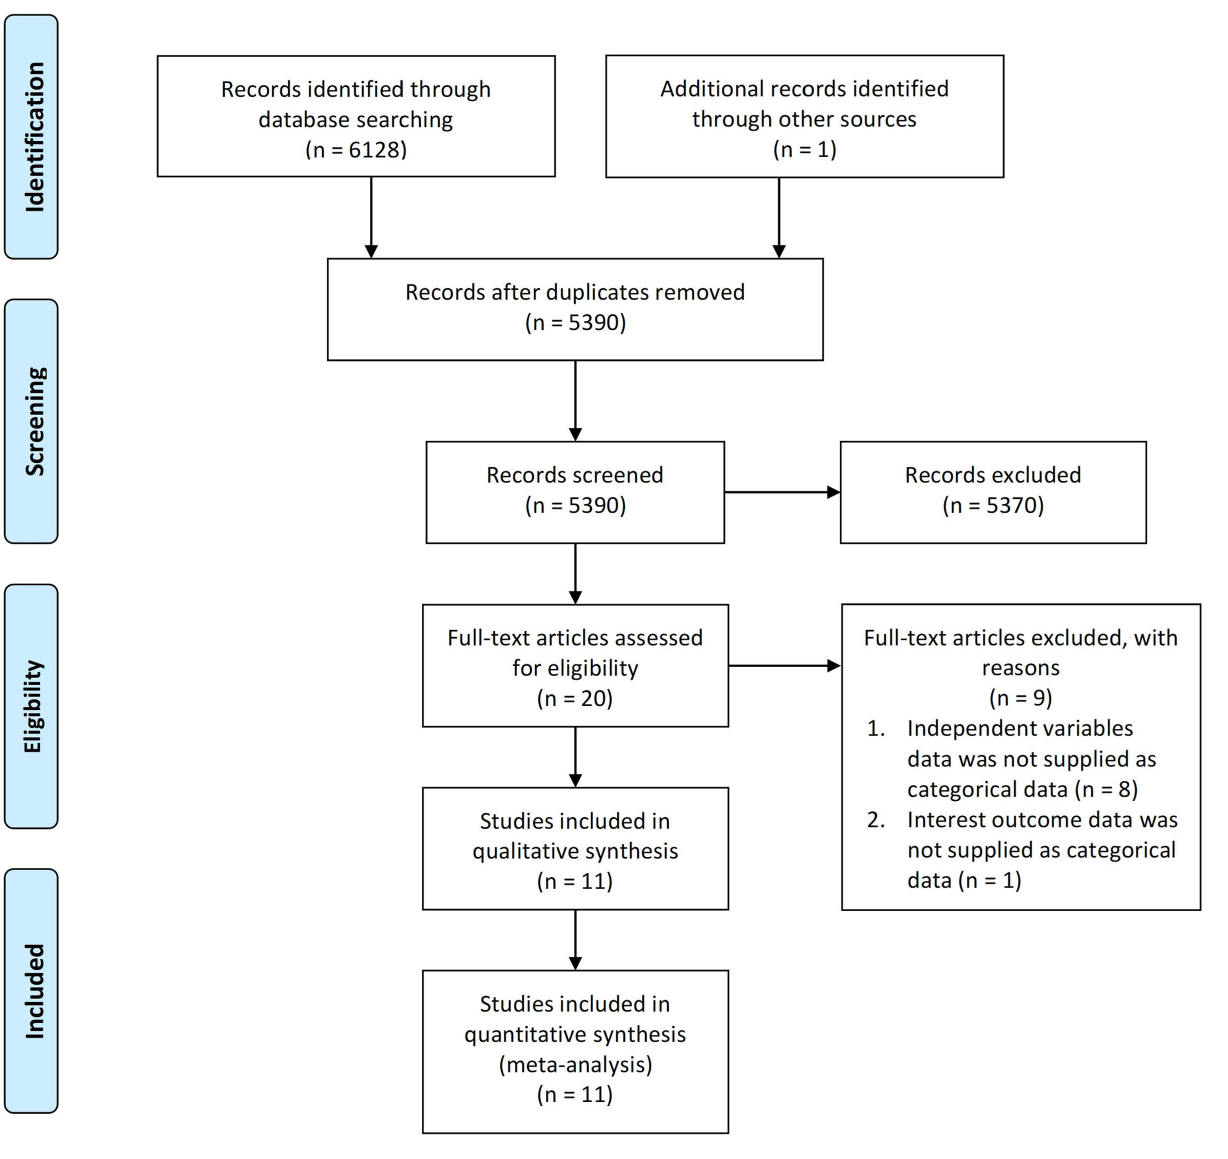
FIGURE 1 | PRISMA